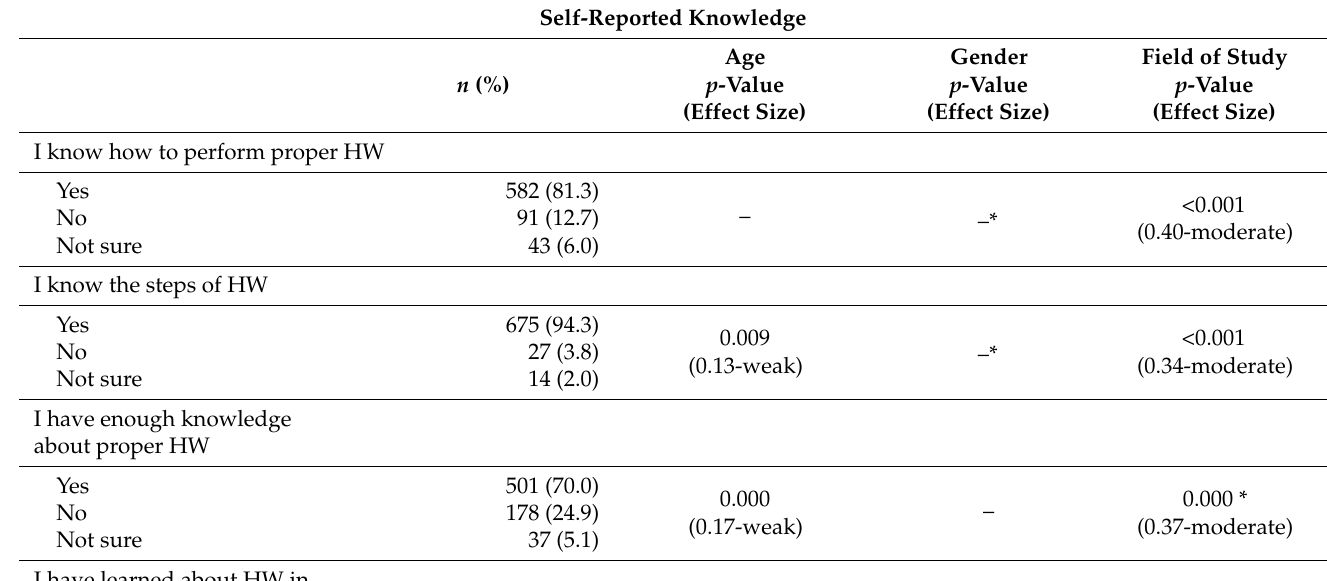
Table 2. Knowledge self-reported by the participants in relation to hand hygiene. Self-Reported